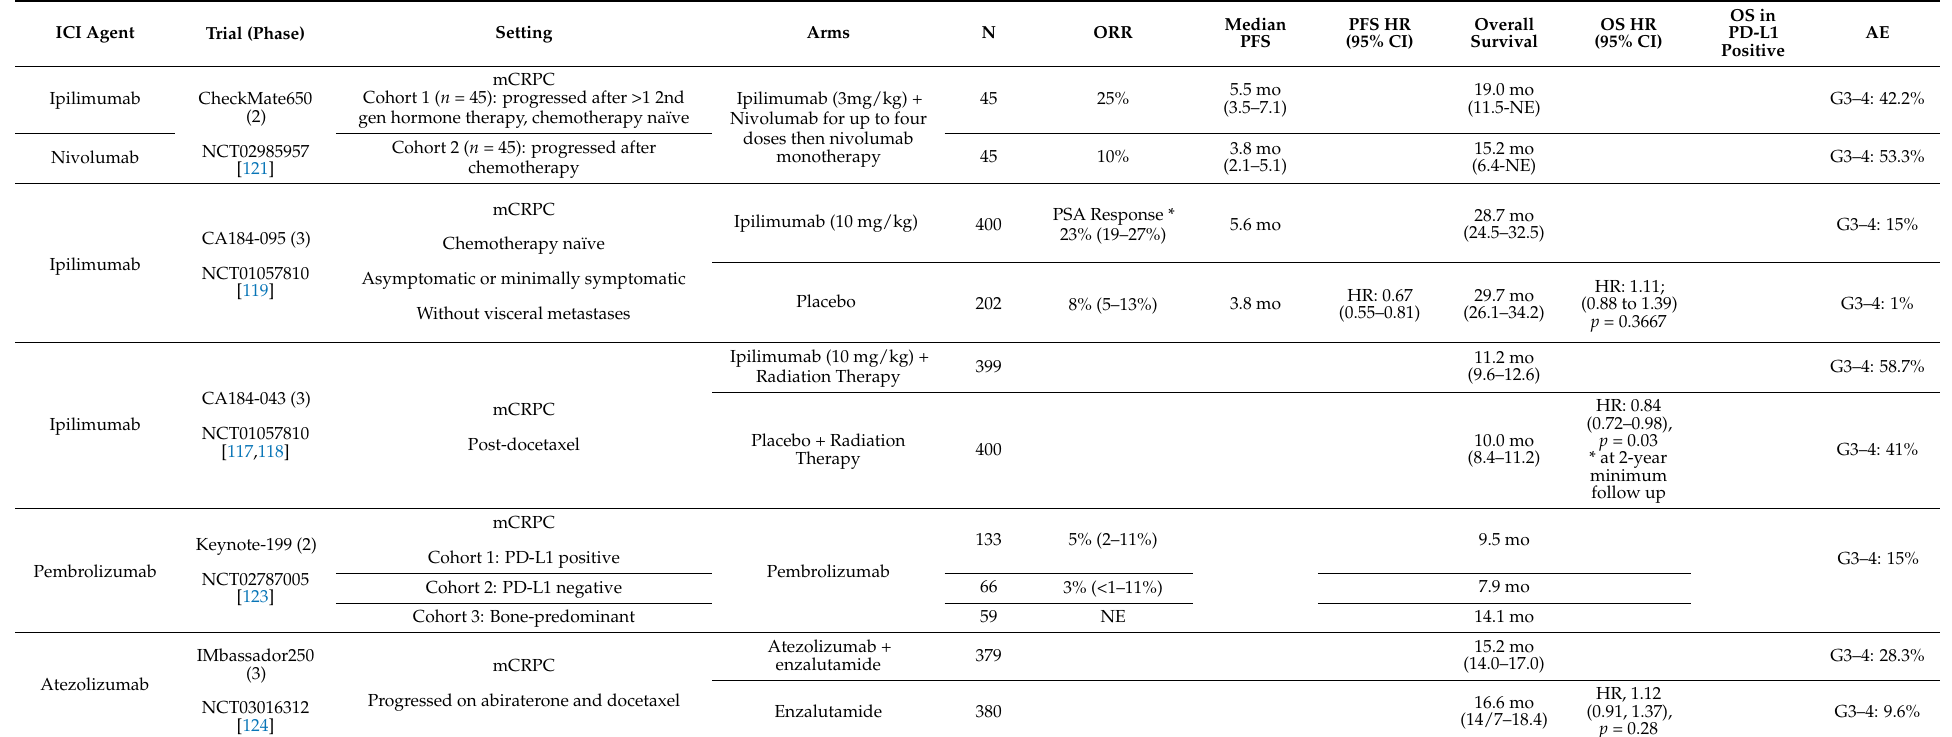
Table 4. ICI clinical trials in prostate